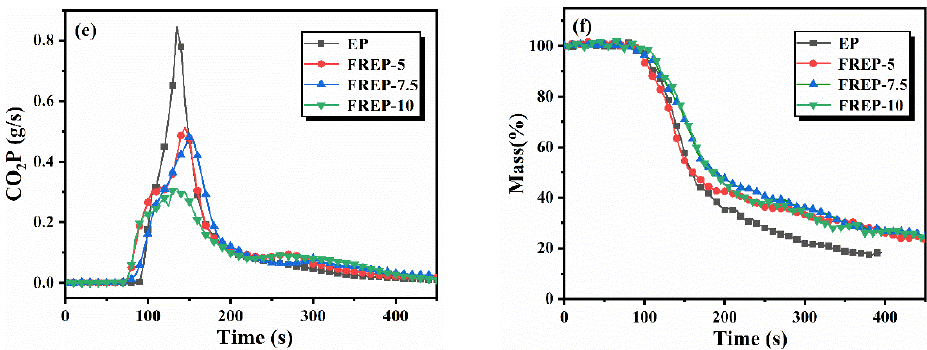
Figure 5. HRR ( a ), THR ( b ), SPR ( c ), TSP ( d ), CO 2 P ( e ), and Mass ( f ) curves of the sample during cone heat combustion. Table 5. Combustion data obtained from CCT.